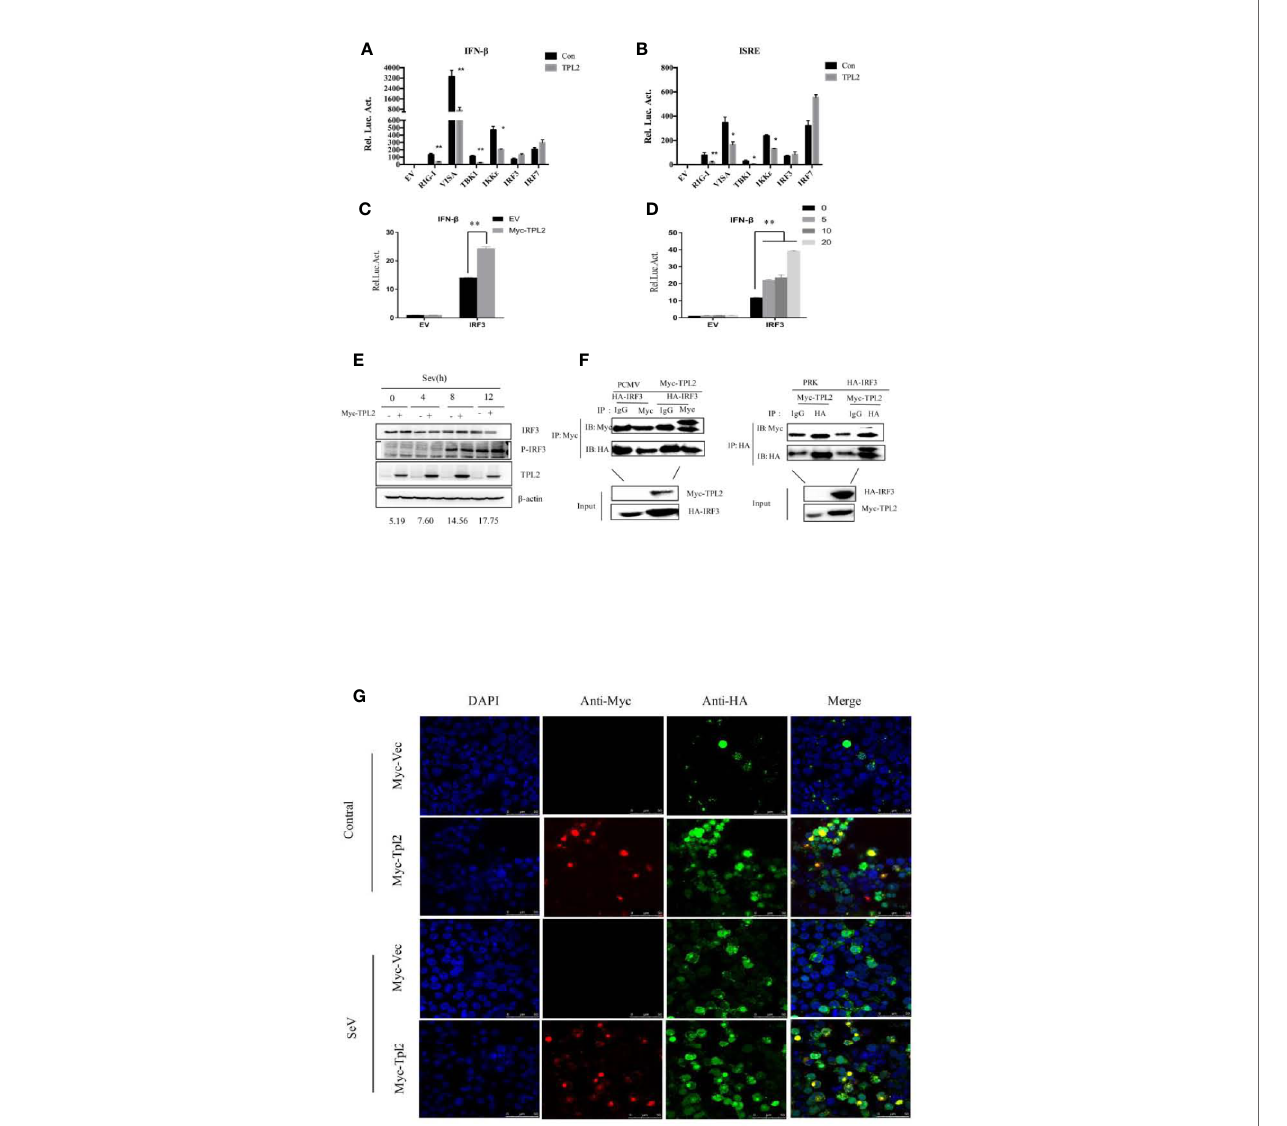
FIGURE 5 | TPL2 regulates virus-triggered signaling at the level of IRF3. (A, B) HEK293T cells were transfected with 100 ng each of ISRE and promoter IFN- b reporter plasmids and 100 ng each of the TPL2 expression plasmid together with expression plasmids for RIG-I, VISA, TBK1 IKK ϵ , and IRF3. After 24 h, reporter analysis was performed. (C, D) Cells were transfected with 0, 5, 10, or 20 ng of the Myc-TPL2 expression plasmid. Cells were collected 24 h later and analyzed using a dual-luciferase reporter assay. (E) Cells were transfected with TPL2/pCMV3N-Myc (1 m g) and were infected with SeV for 24 h and collected at 0, 4, 8, 12 h after infection. The results were compared with no-transfection controls. (F) HEK293T cells were transfected with expression plasmids encoding HA-IRF3 and Myc- TPL2 (5 m g each). (G) HEK293T cells were transfected with expression plasmids encoding HA-IRF3 and Flag-TPL2 (0.5 m g each). After 24 h, cells were left untreated or infected with SeV. Immuno fl uorescence experiments were performed 12 h